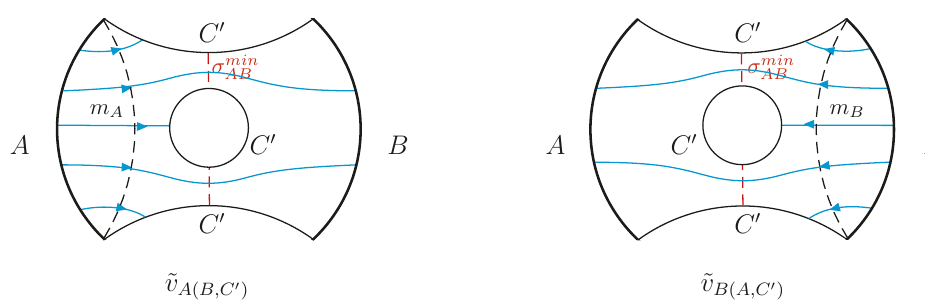
Figure 7 . The vector (cid:12)eld ~ v , a (cid:13)ow that simultaneously maximizes the (cid:13)ux A ! (cid:22) A (bounded A ( B;C 0 ) above by the area of m A ) and the (cid:13)ux A ! B (bounded above by the area of (cid:27) min ). The threads AB connecting A to B must cross the surface (cid:27) min , and can not end on surface C 0 (including the AB horizon). Similarly for the vector (cid:12)eld ~ v . Where we suppose that the horizon is a part B ( A;C 0 ) of the auxiliary system C 0 needed to purify system AB , and j (cid:9) i ABC 0 is a minimal entanglement puri(cid:12)cation of (cid:26) AB